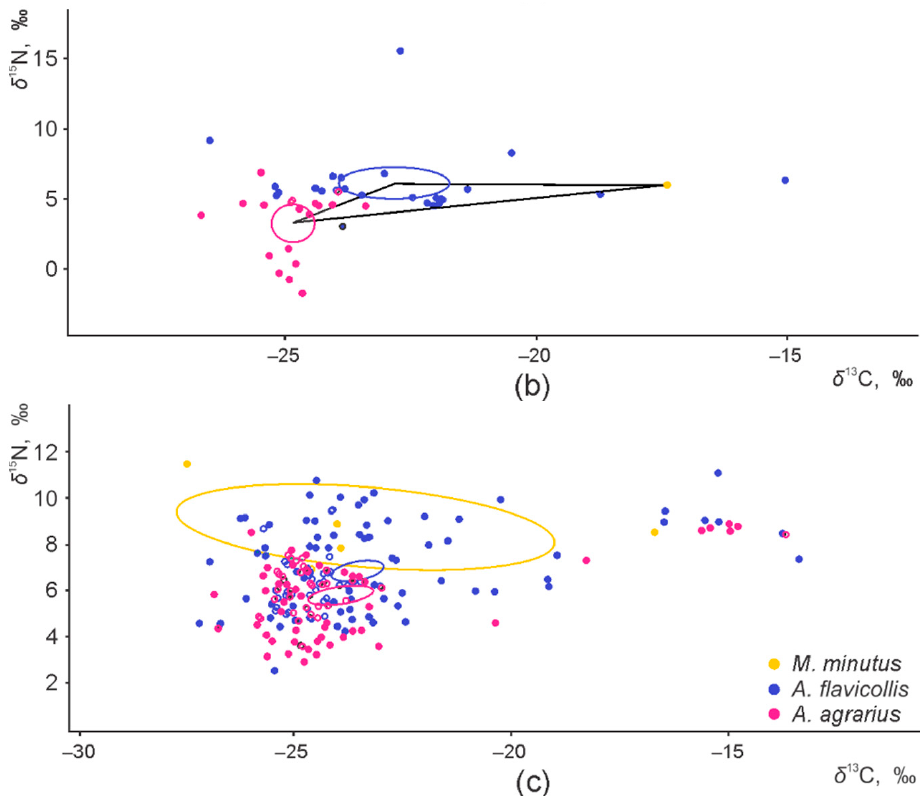
Figure 3. Central ellipses of the three syntopic granivorous species in the isotopic space, representing fundamental niches in apple orchards ( a ), raspberry plantations ( b ), and control habitats ( c ). In the apple orchards, control habitats, and raspberry plantations, the total area of the trophic niche was widest in A. agrarius . The central niche in central habitats was widest in M. minutus (see also Figure 3c). In the plum orchards, the widest trophic niche was characteristic to A. flavicollis (Table S2); please note, that area cannot be calculated in the small ( n < 5) sample size (Figure S2b, Table